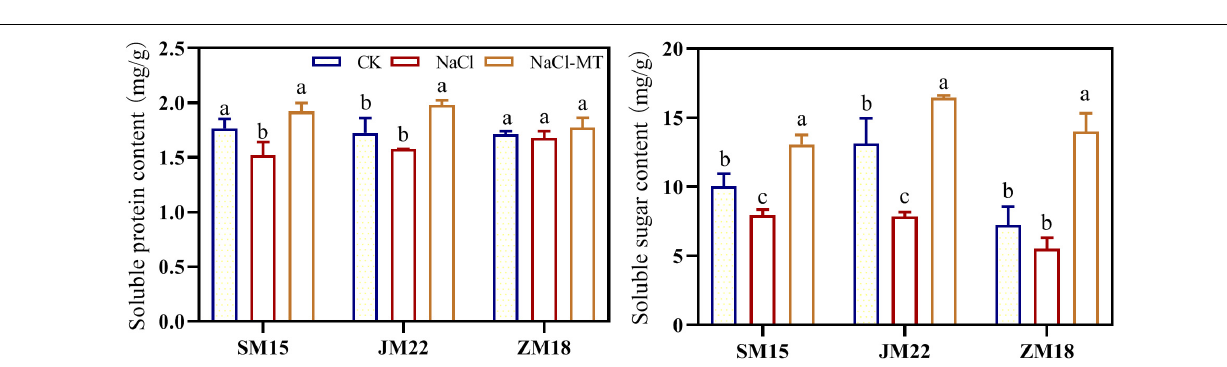
FIGURE 5 | Effects of MT on soluble protein and sugar content under salt stress. For each trait, bars with the same letter are not significantly different according to Duncan’s test at a p < 0.05